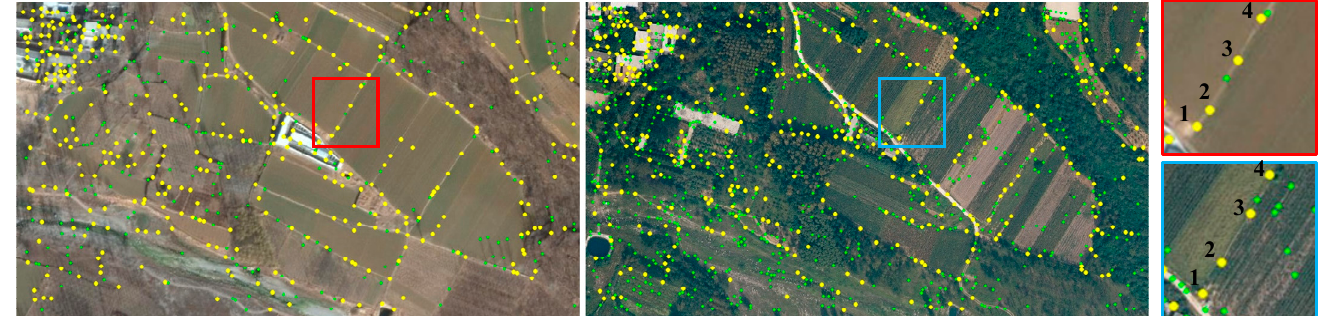
Figure 23. Distribution of feature points. The yellow point is the correct matching, and the green point denotes the incorrect matching point. On the right is a partially enlarged view of the same position in the two images.